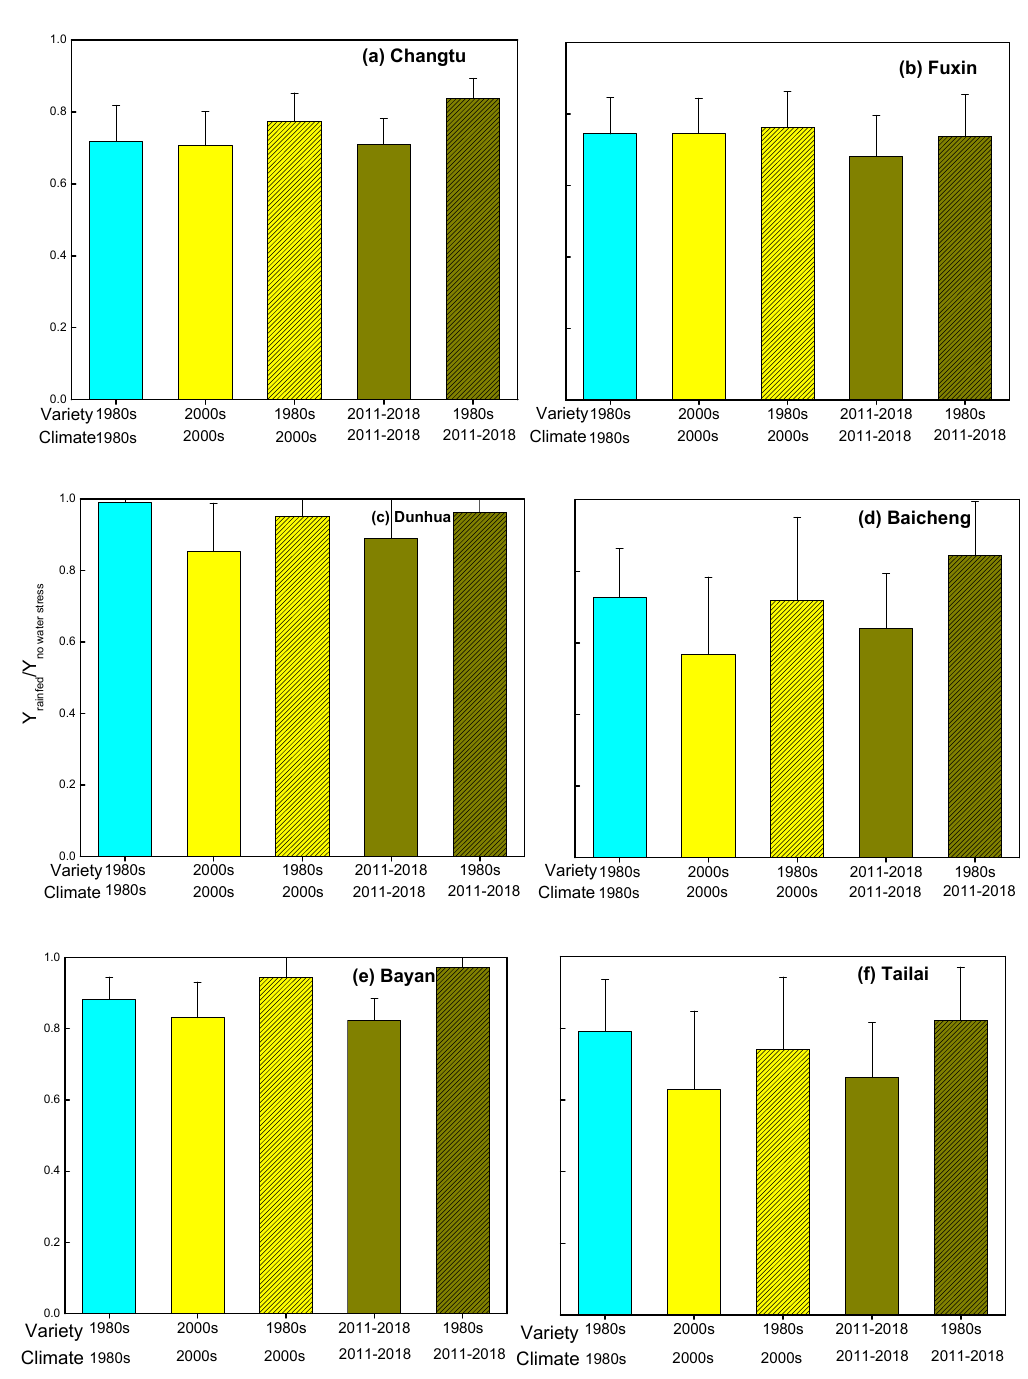
Figure 5. Ratios of simulated rainfed yield to no water-stress yield for combinations of variety (varieties planted in the 1980s and 2000–2018) and climate (climate in the 1980s and 2000–2018) for humid region ( a , c , e ) and semi-humid region ( b , d , f ) stations. Error bars indicate standard deviations.